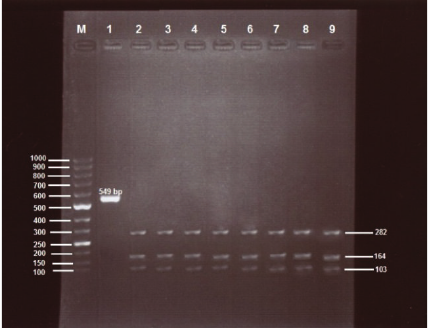
Figure 2: PCR and RFLP profile of amplified 549 bp fragment of the B. ovis -specific ssu rRNA gene. Lane M: 50 bp DNA ladder (Fermentas, Germany), lane 1: undigested PCR product, lane 2: digested PCR product from infected sheep, lane 3: digested PCR